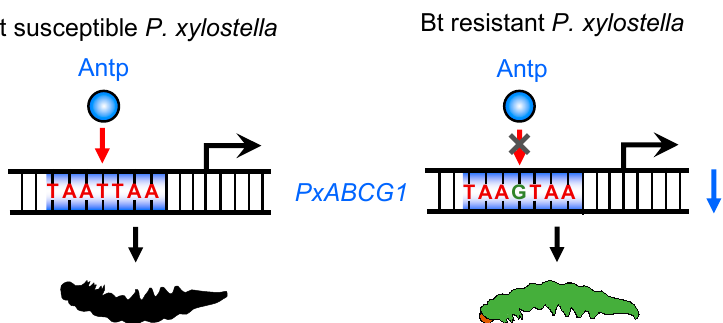
Figure 6. Schematic of the transcriptional regulation of reduced PxABCG1 expression . In the Cry1Ac resistant strain P. xylostella , a cis -acting mutation in the binding site of Antp prevents Antp binding and downregulates PxABCG1 expression, thereby enhancing larval resistance to Cry1Ac toxin. The black larva denotes larval death, and the green larva represents larval survival.